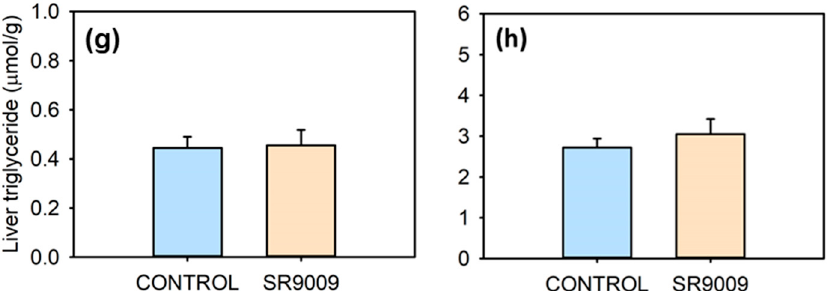
Figure 6. Effect of acute and subchronic SR9009 treatment on liver metabolites. Hepatic glucose ( a , b ), glycogen ( c , d ), fatty acid ( e , f ), and triglyceride ( g , h ) in goldfish ( Carassius auratus ) treated